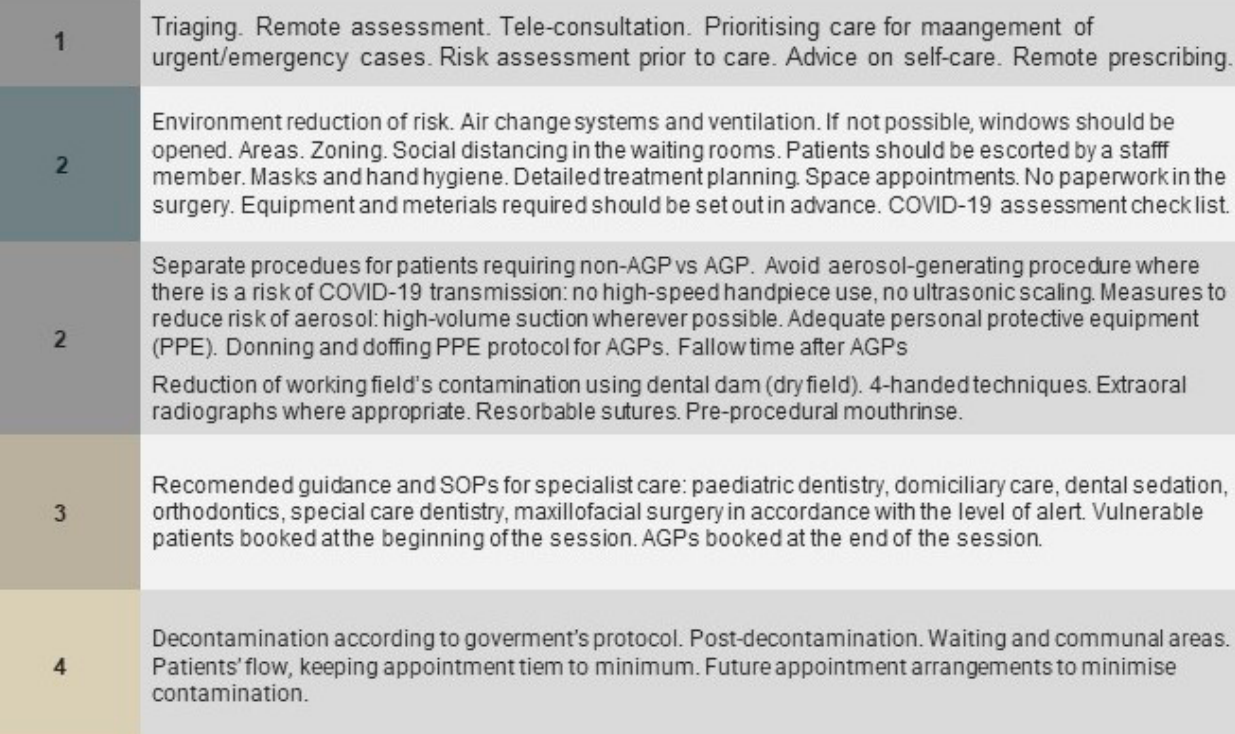
Figure 3. The essential elements of standard operating procedures applicable for the dental service. Rapid Antigen Tests: A Gamechanger?